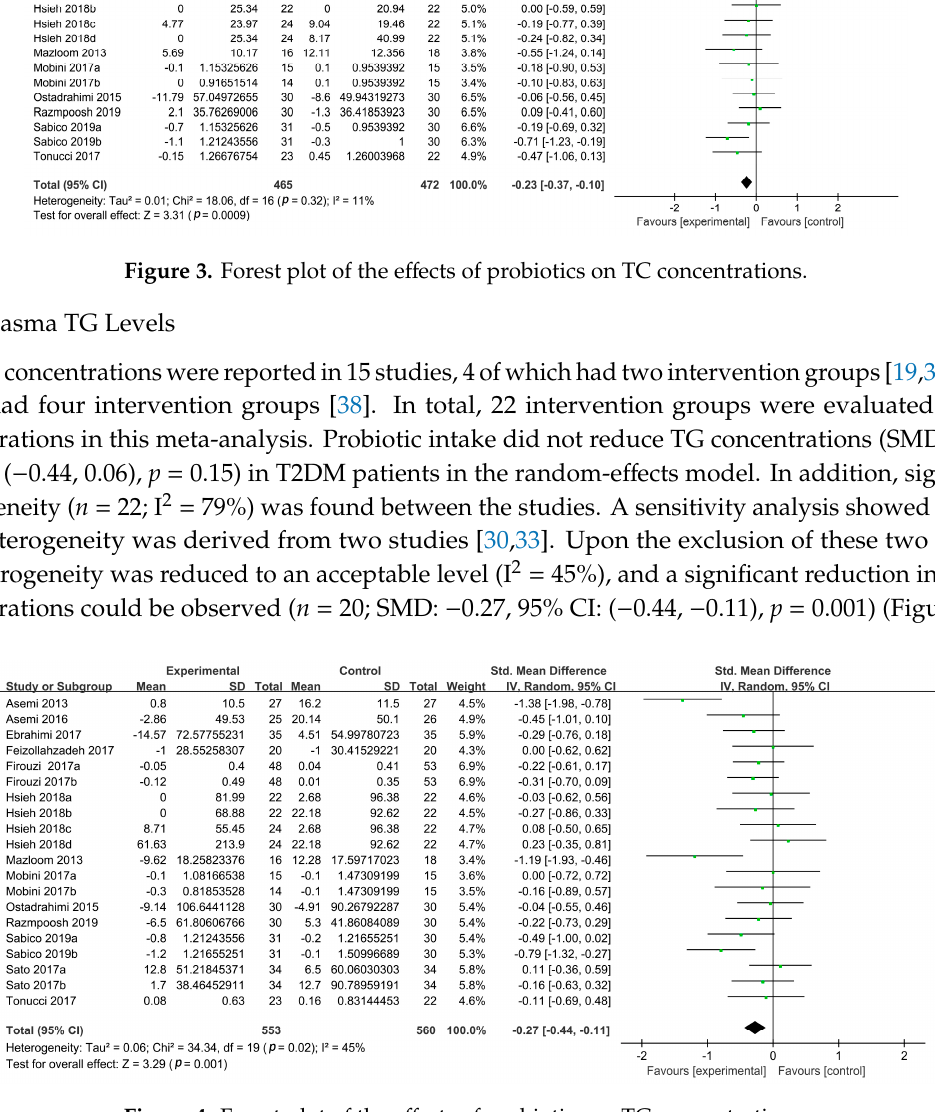
Figure 4. Forest plot of the effects of probiotics on TG concentrations.